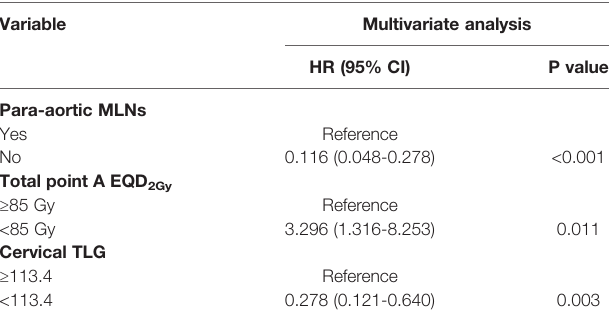
TABLE 4 | Results of the multivariate analysis of clinical factors for disease-free